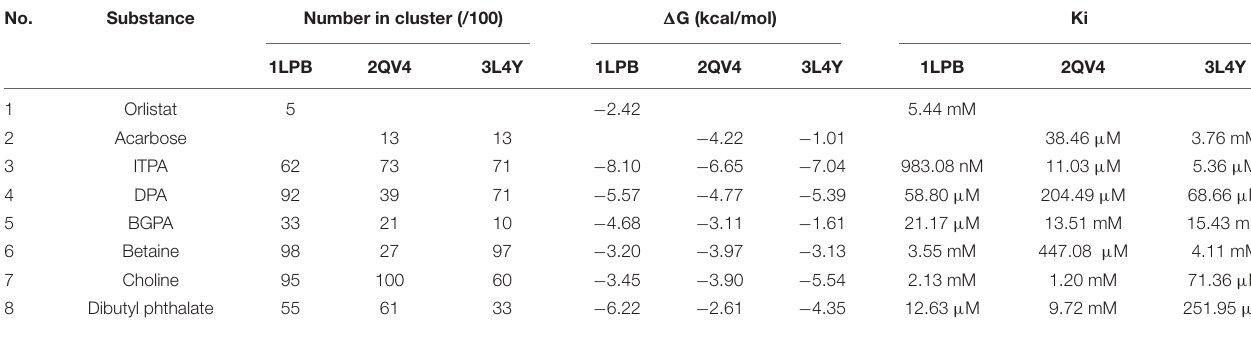
TABLE 3 | Molecular docking parameter of C. racemosa major compounds. No.